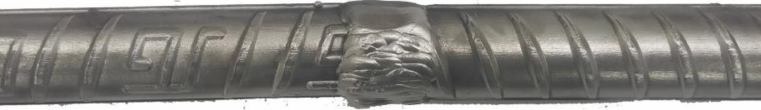
Figure 24. Surface profile of the specimen after rust